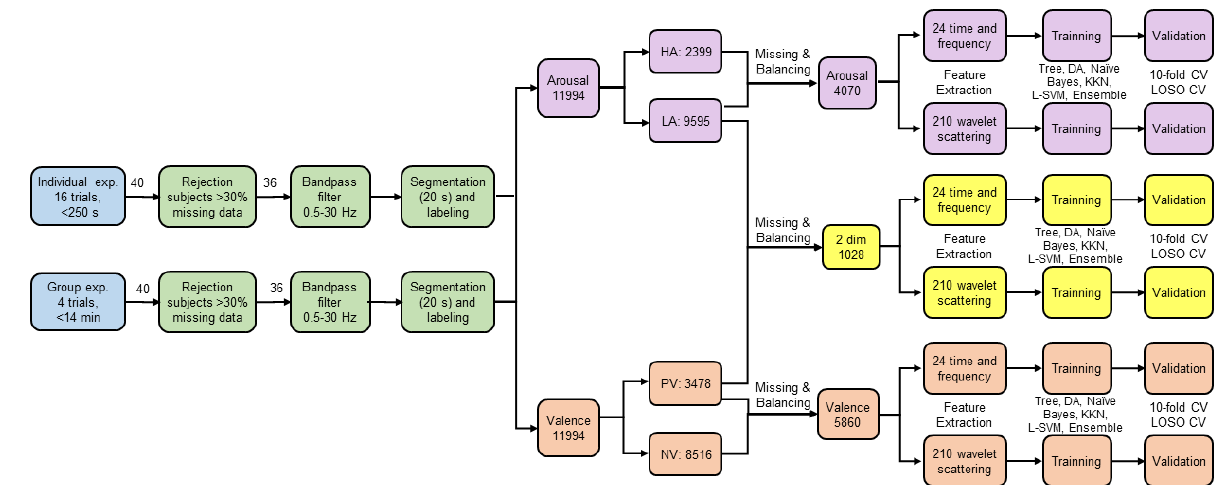
Figure 3. Block diagram of the algorithm used for classification. PV—positive valence; NV—negative valence; HA—high arousal; LA—low